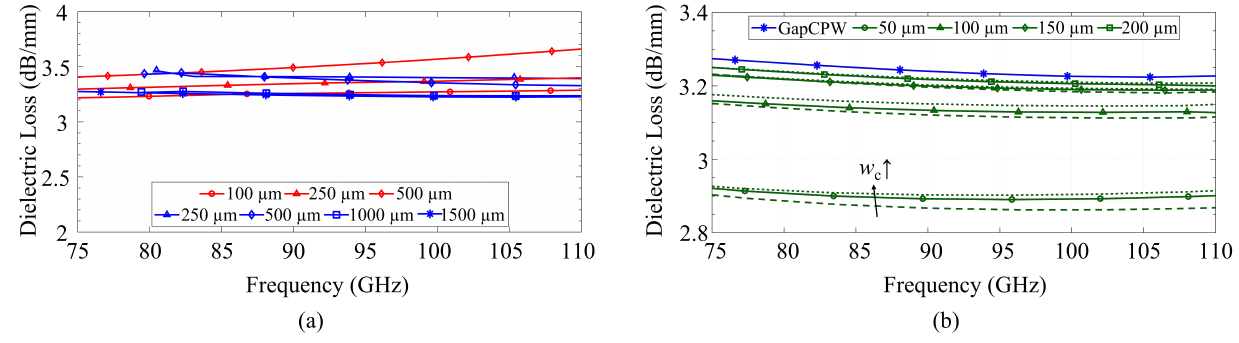
Figure 12. Dielectric loss associated with a silicon substrate with a resistivity of 10 Ω · cm. ( a ) Compari- son between CB-CPW (red) and GapCPW(blue) for different lateral ground extension. ( b ) Comparison between GapCPW (blue) and IGCPW (green) for different channel heights and widths. Channel width in ( b ) is represented by dashed lines (350 µ m), solid lines (450 µ m) and dotted lines (550 µ